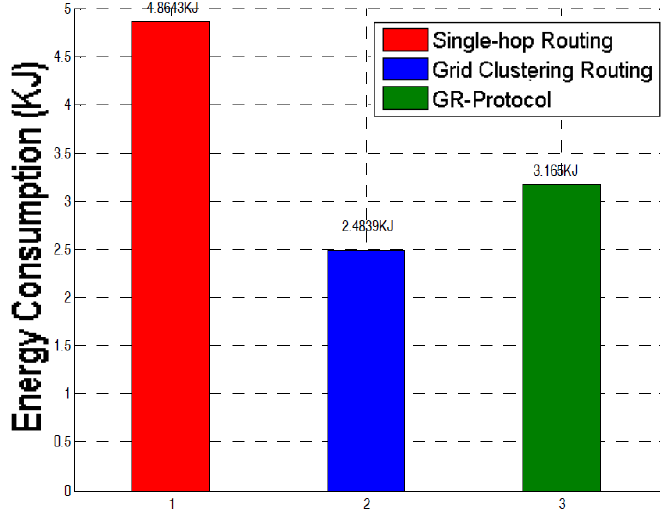
Figure 13. Energy consumption of 50 deployed nodes.